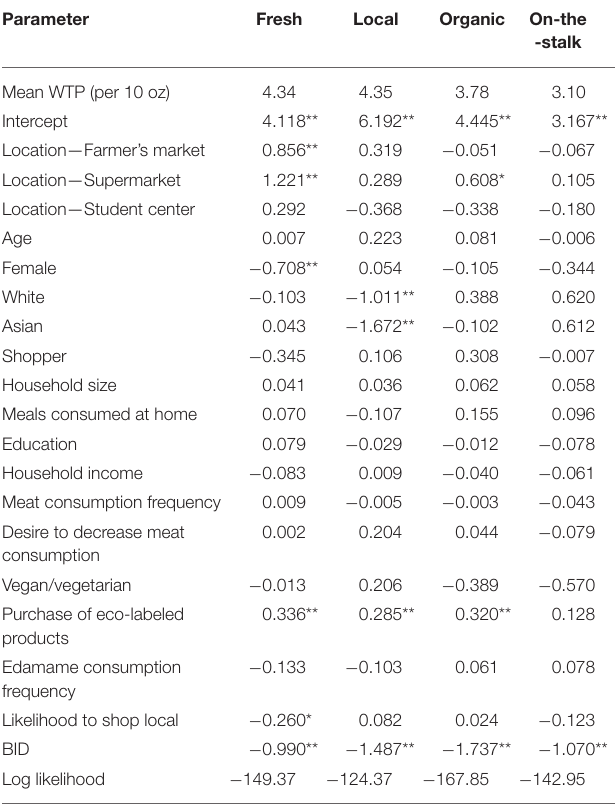
TABLE 3 | WTP estimates for edamame marketed as fresh, local, organic, and on the stalk ( N = 188). Parameter Fresh Local Organic On-the